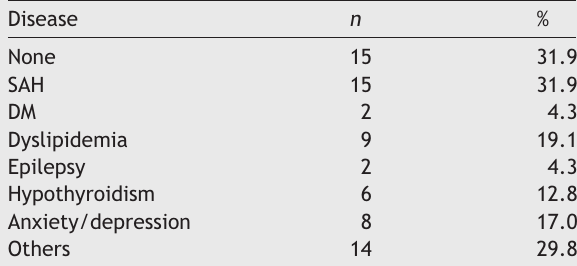
Comorbidities in patients with VM.